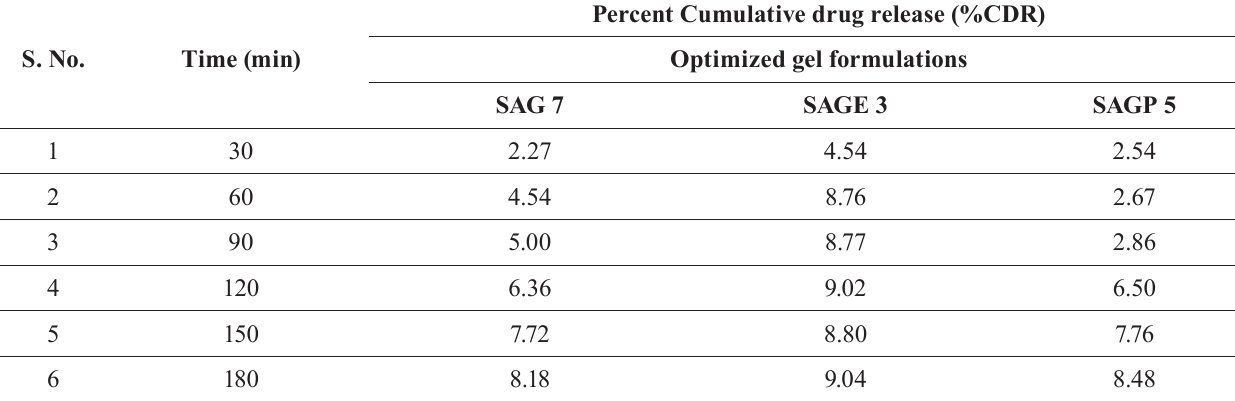
TABLE IV - Cumulative drug release of optimized formulations, SAG, SAGE and SAGP